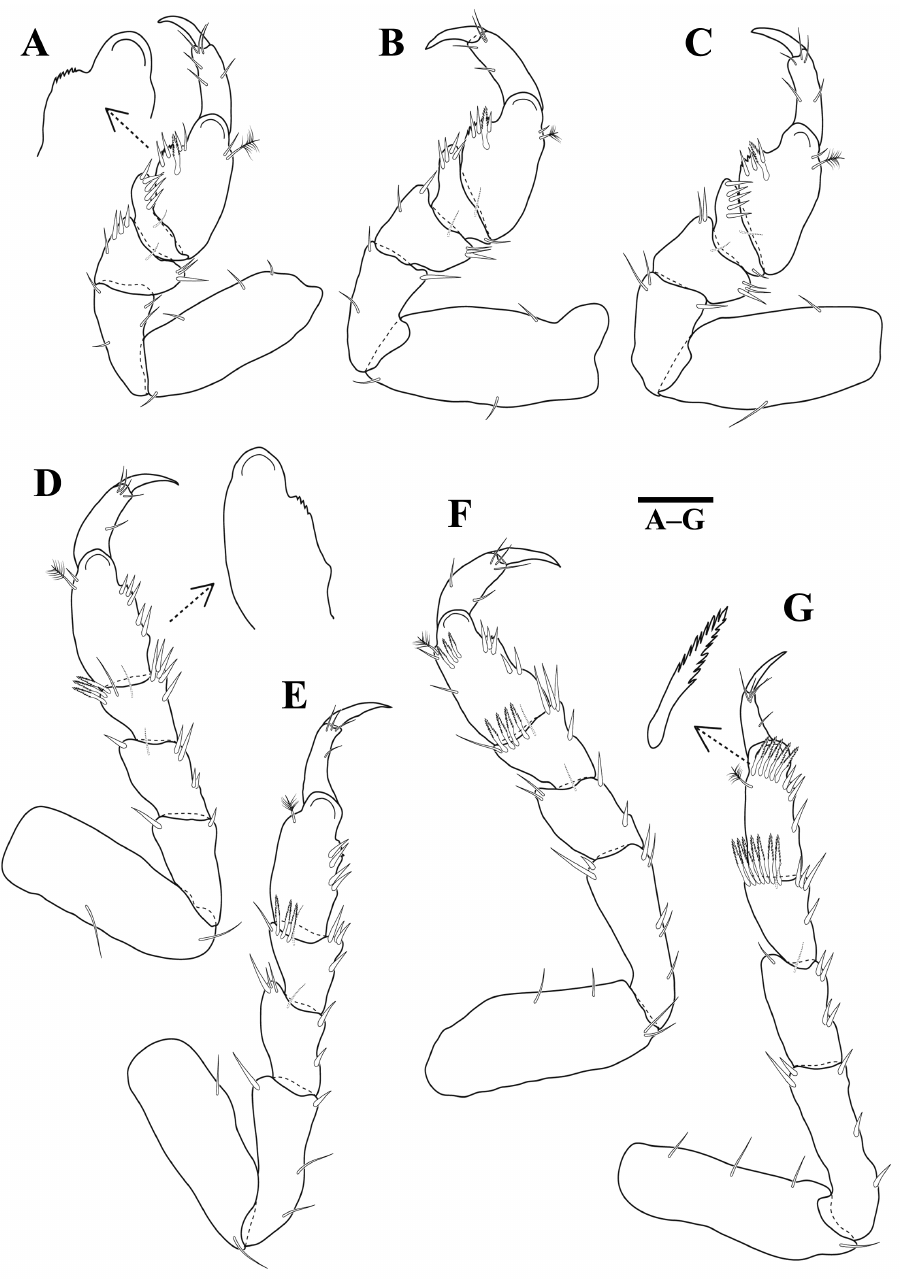
Figure 6. Tachaea koreaensis sp. n., female holotype. A pereopod 1 B pereopod 2 C pereopod 3 D pereo- pod 4 E pereopod 5 F pereopod 6 G pereopod 7. Scale bars: 0.2 mm ( A–G